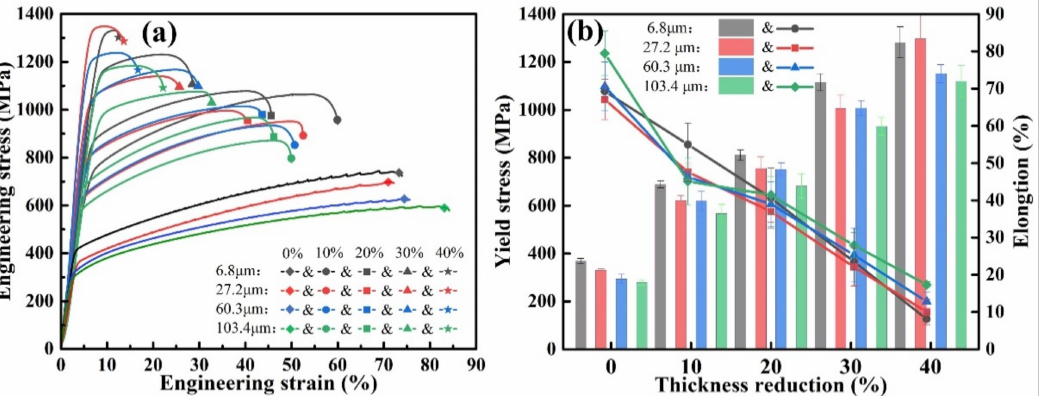
Figure 3. Tensile properties of Fe-18Mn-1.3Al-0.6C samples under different rolling reduction: ( a ) Engineering stress-strain curve; ( b ) Ultimate strength and elongation corresponding to ( a